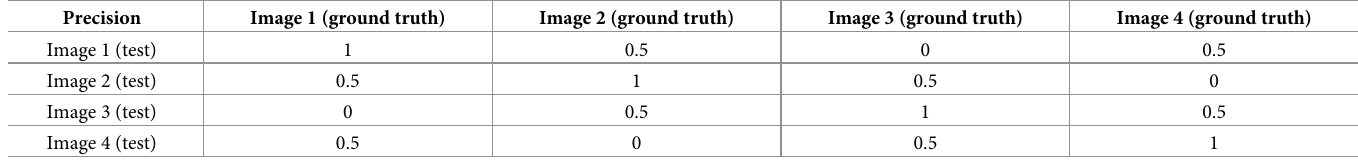
Table 1. Precision values output from POSEA evaluation of simulated binary images (Fig 2) that are half-white and half-black either horizontally divided (Image 1, Image 3) or vertically divided (Image 2, Image 4). Precision Image 1 (ground truth) Image 2 (ground